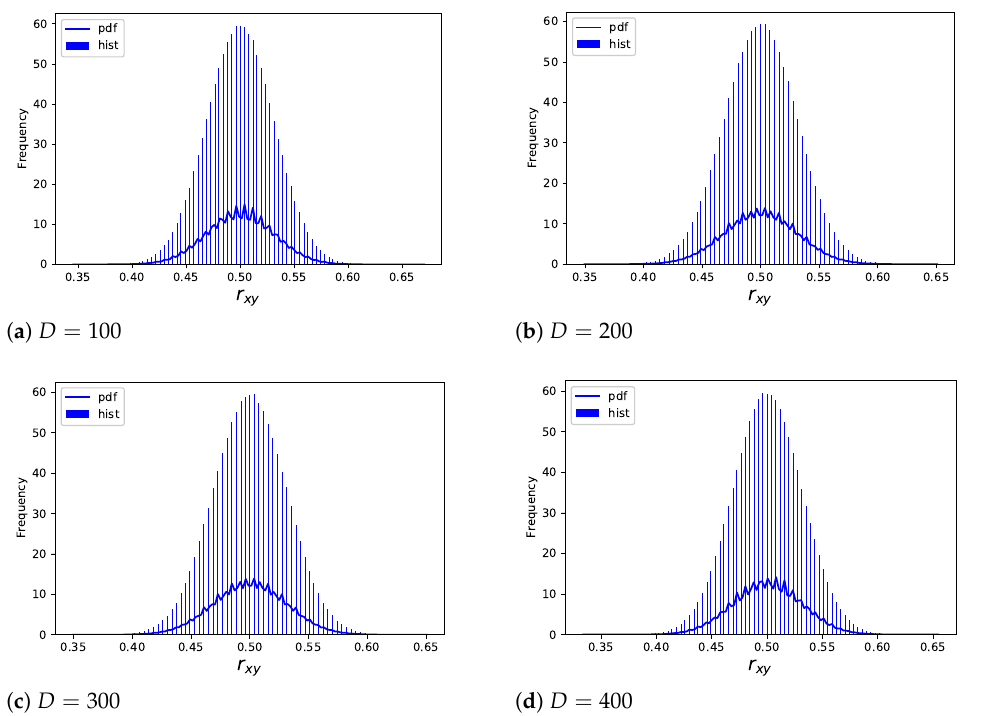
Figure 15. Correlation (measured by r xy ) as D